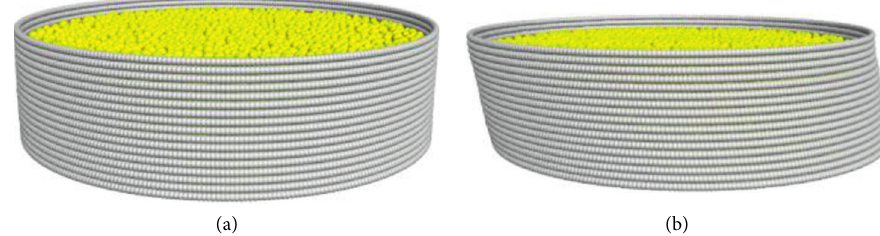
Figure 7: Particle arrangement in DEM model. (a) Particles after consolidation. (b) Particles at